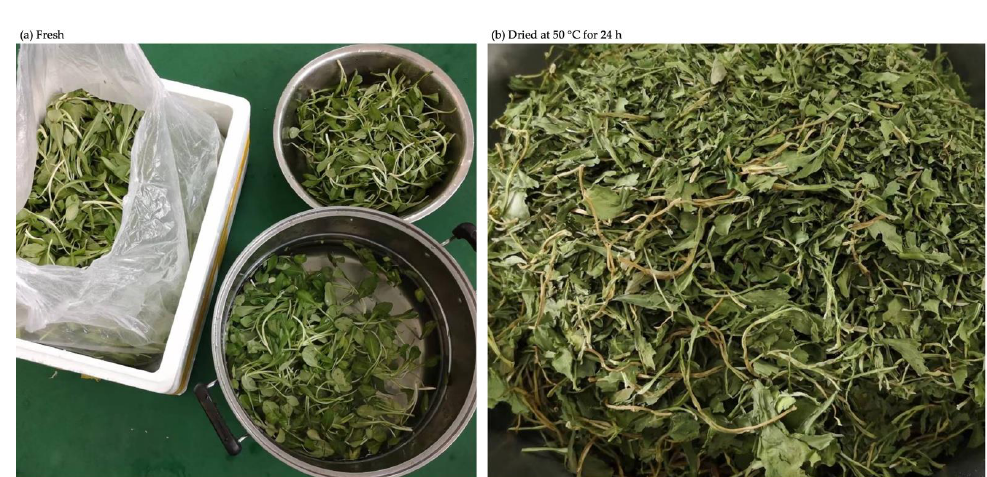
Figure A1. The younger leaves of malan ( Kalimeris indica (L.) Sch. Bip.) are usually eaten as a vegetable, commonly known as “malanto”. ( a ) Fresh; ( b ) Dried at 50 °C for 24 h.